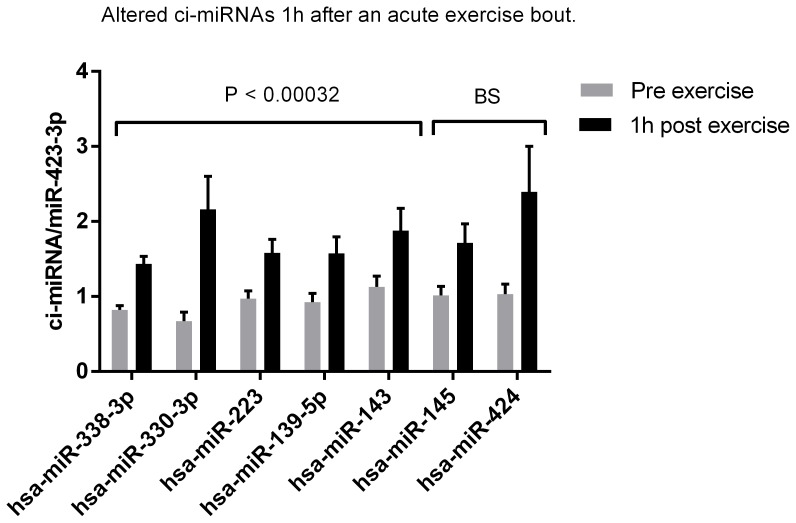
Alterations in resting ci-miRNAs in plasma one hour after an acute exercise bout.Five ci-miRNAs were up regulated 1 hour after a 60 min aerobic exercise bout at 65% Pmax when Dunn-bonferroni correction of the significance level 0.05 was performed (P<0.00032). Additional two miRNAs were borderline significant (BS) up regulated at significance level 0.001.